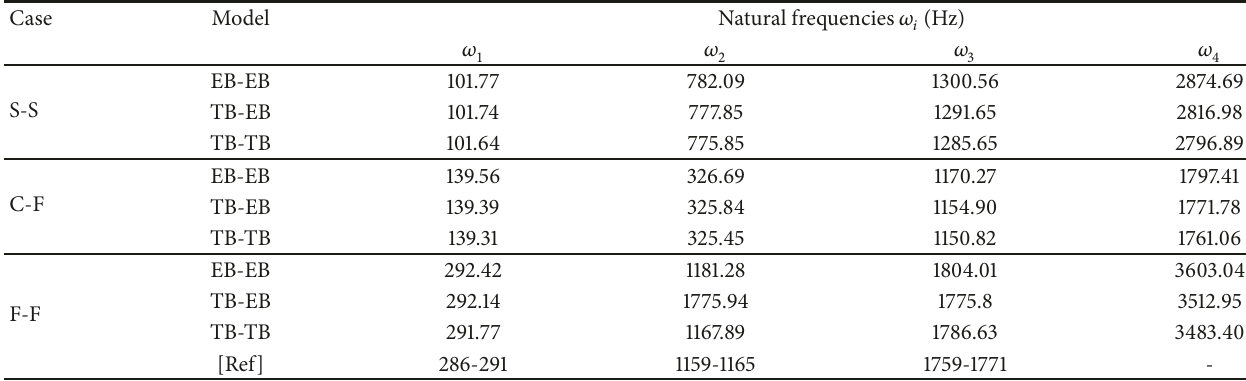
Table5:Comparisonofnaturalfrequenciesfromthedouble-spanbeam.EB-EB:twosegmentsofEuler-Bernoullibeam,TB-TB:twosegments of Timoshenko beam, and TB-EB: first segment using Euler-Bernoulli beam model and second segment using Timoshenko beam model.